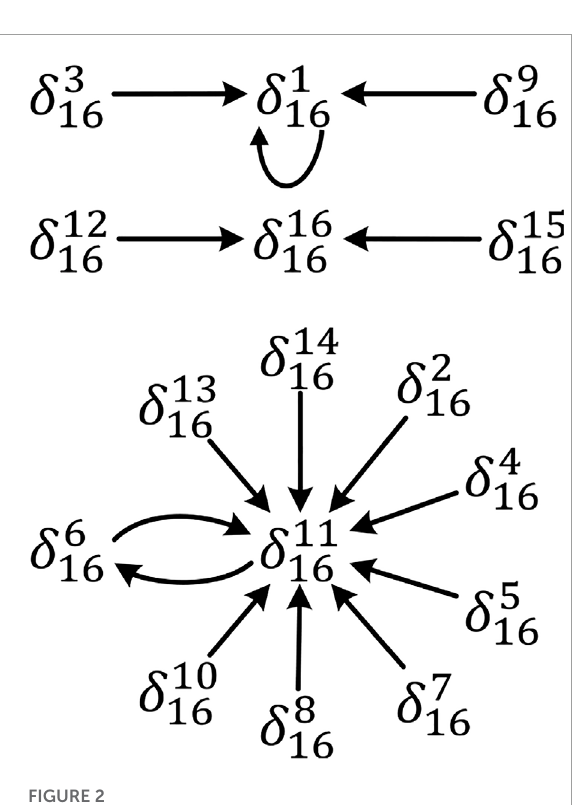
FIGURE 2 The state transition diagram of system (16).